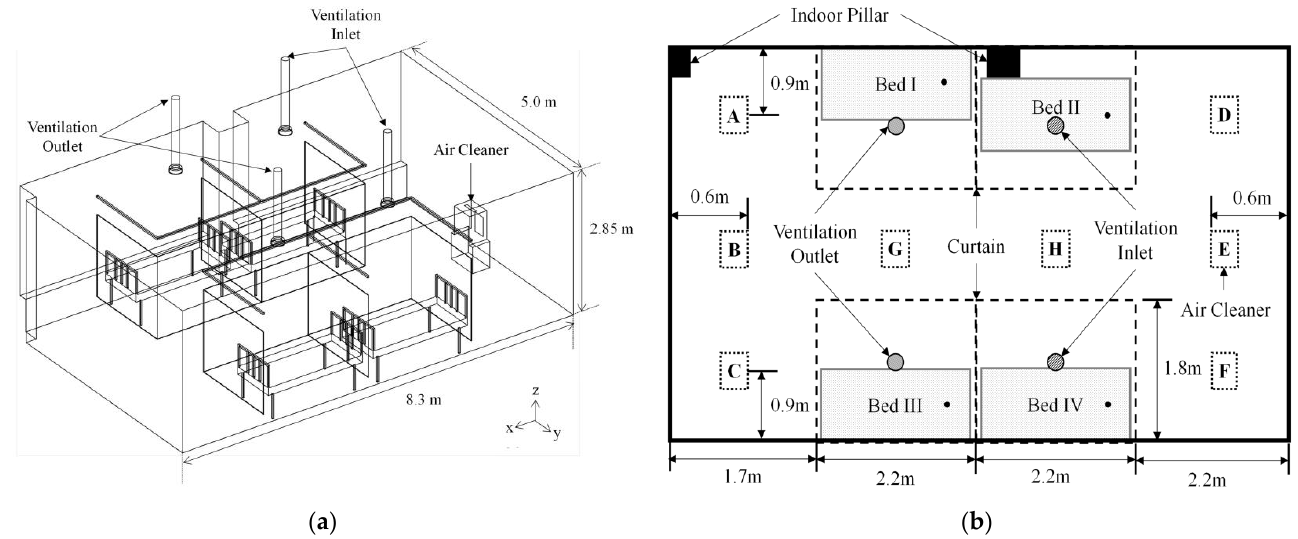
Figure 1. Laboratory configuration. ( a ) Isometric view; ( b ) Plan view.